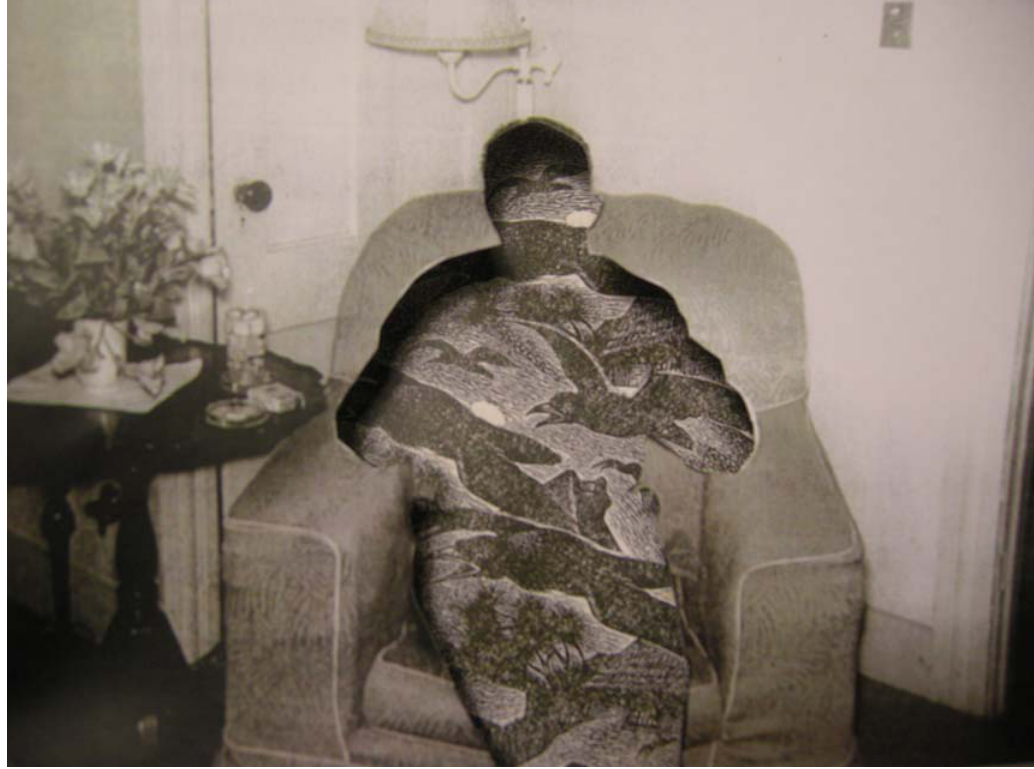
Figure 2. Collage from photograph of Peter Clapps reading in his chair and images from his beloved copy of Wuthering